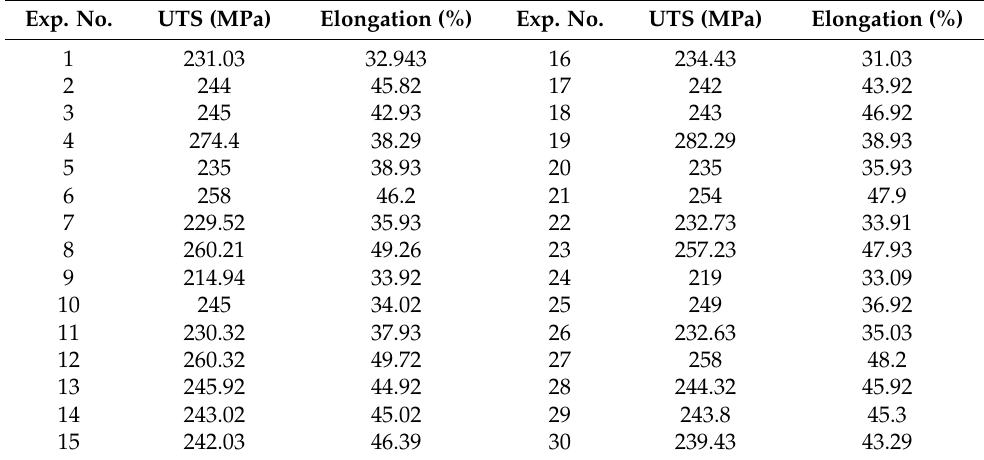
Table 4. The results of UTS and elongation according to the Box–Behnken